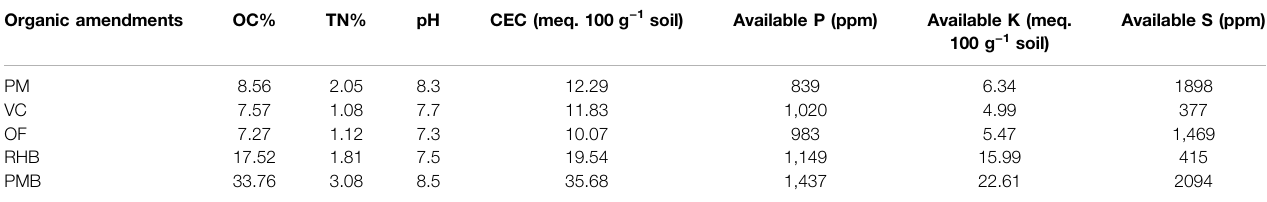
TABLE 2 | Chemical properties of organic amendments. Organic